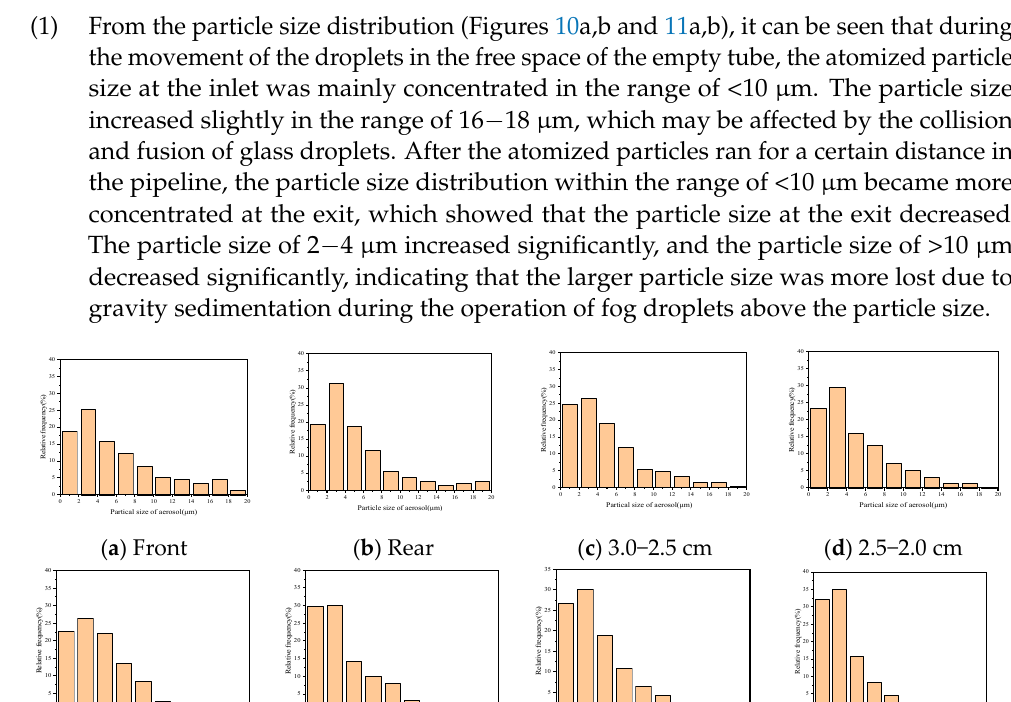
Figure 12. Statistical chart of particle size.